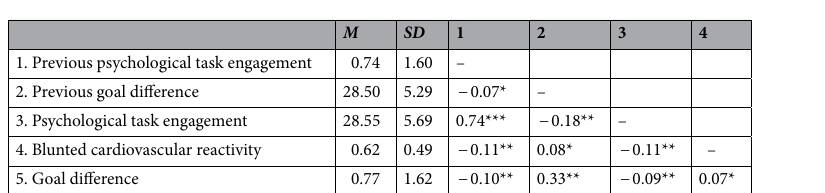
Figure 2. Path Model for Role of Task Engagement in Motivated Performance . Note. Blunted cardiovascular reactivity coded 0 = not blunted, 1 = blunted. Dashed lines represent insignificant paths. * p < 0.05, ** p < 0.01, *** p < 0.001.